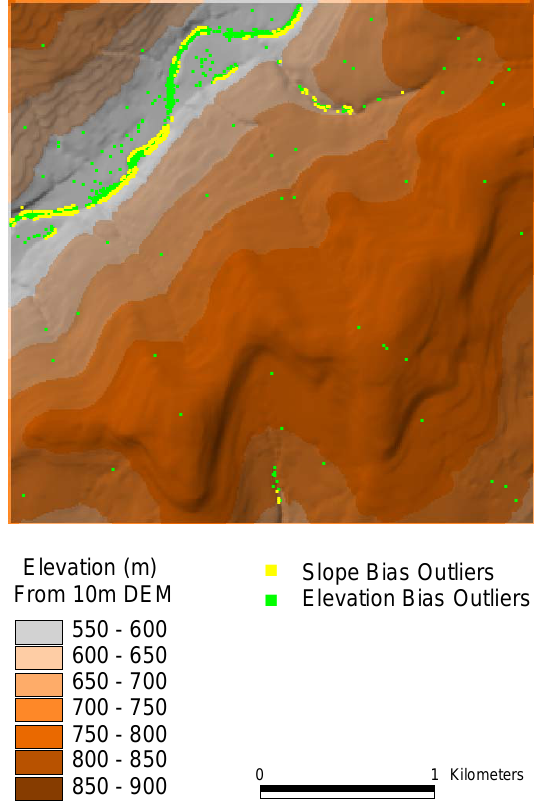
Fig. 1. Topographic locations of bias outlier points due to sink fill- ing. Points contributing to positive elevation bias and negative slope Figure 1 : Topographic locations of bias outlier points due to sink filling. Points bias were extracted from results of a Monte Carlo Simulation (ele- contributing to positive elevation bias and negative slope bias were extracted from vation bias values greater than 1.61 and slope bias values less than results from a Monte Carlo Simulation (elevation bias values greater than 1.61and slope − 3.78). Locations tend to coincide, falling in valley areas or loca- bias values less than –3.78). Locations tend to coincide, falling in valley areas or tions with relatively flat locations with relatively flat slopes.